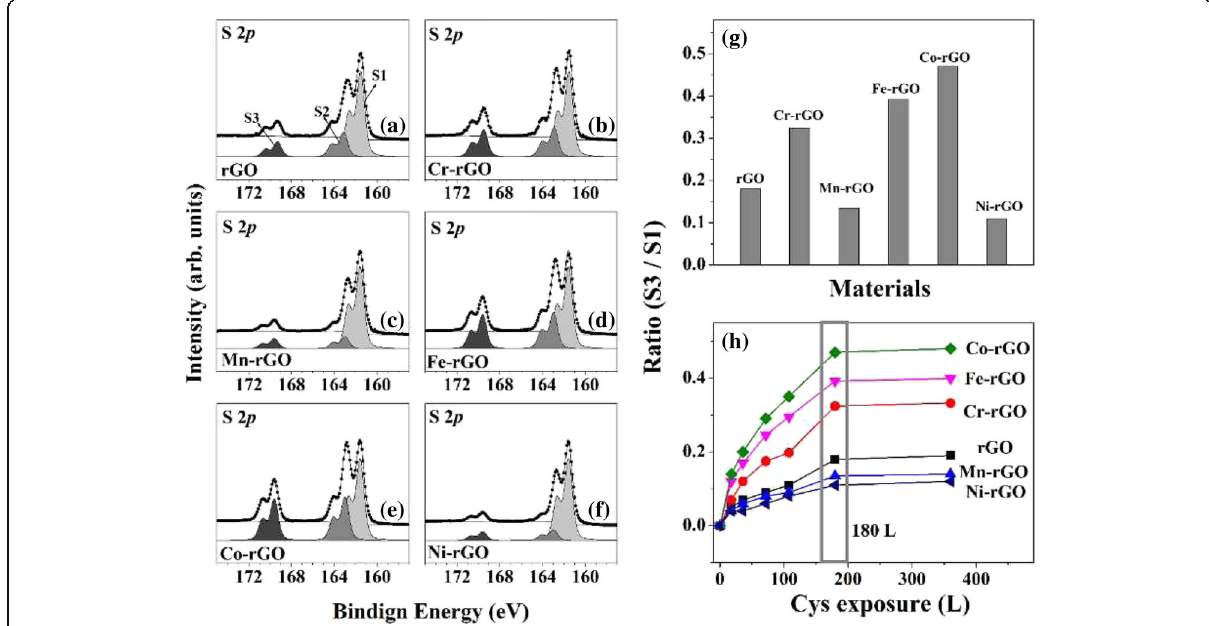
Fig. 3 HRPES S 2 p core-level spectra of the products of the photocatalytic oxidations of Cys (180 L) carried out in the presence of 5 wt % a rGO,